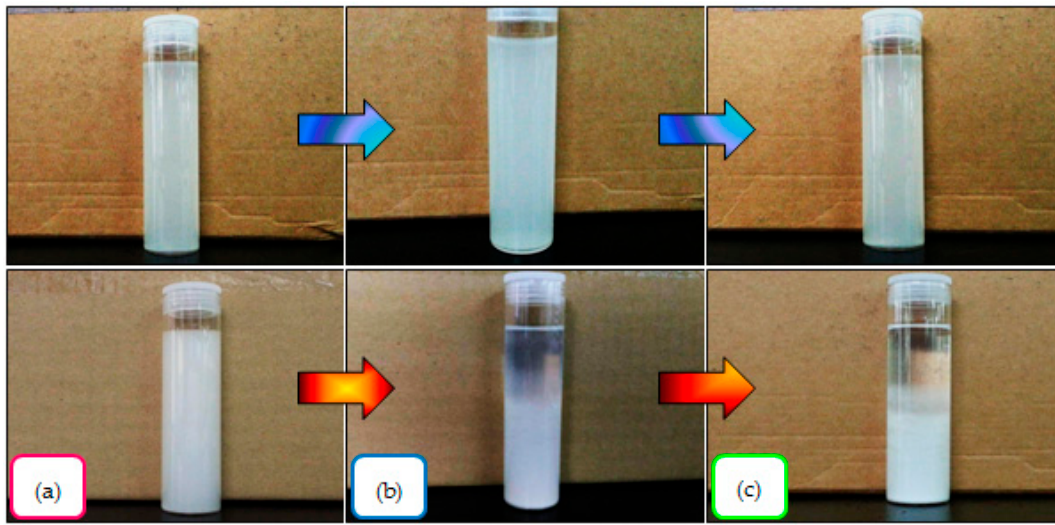
Figure 7. The electronic photos of the CNC H2SO4 ( top ) and CNC Cr(NO3)3 ( bottom ) suspension obtained at different period: ( a ) Right after sonication treatment; ( b ) After 24 h; and ( c ) After 7 days.